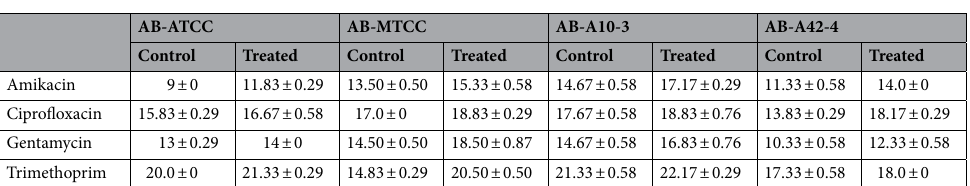
Table 2. Antibiotic sensitivity pattern of AB strains in the absence and the presence of